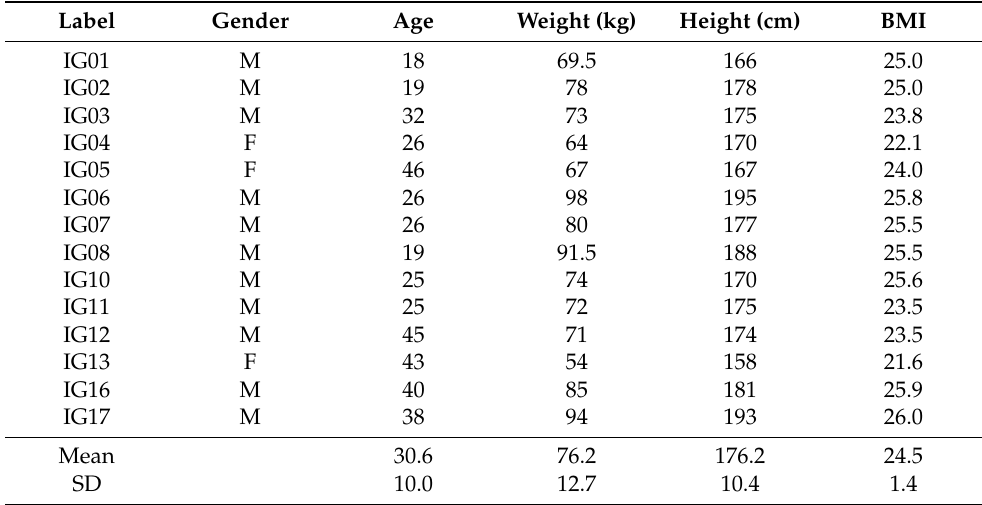
Table 1. Data on volunteers enrolled in the study (BMI = Body Mass Index).